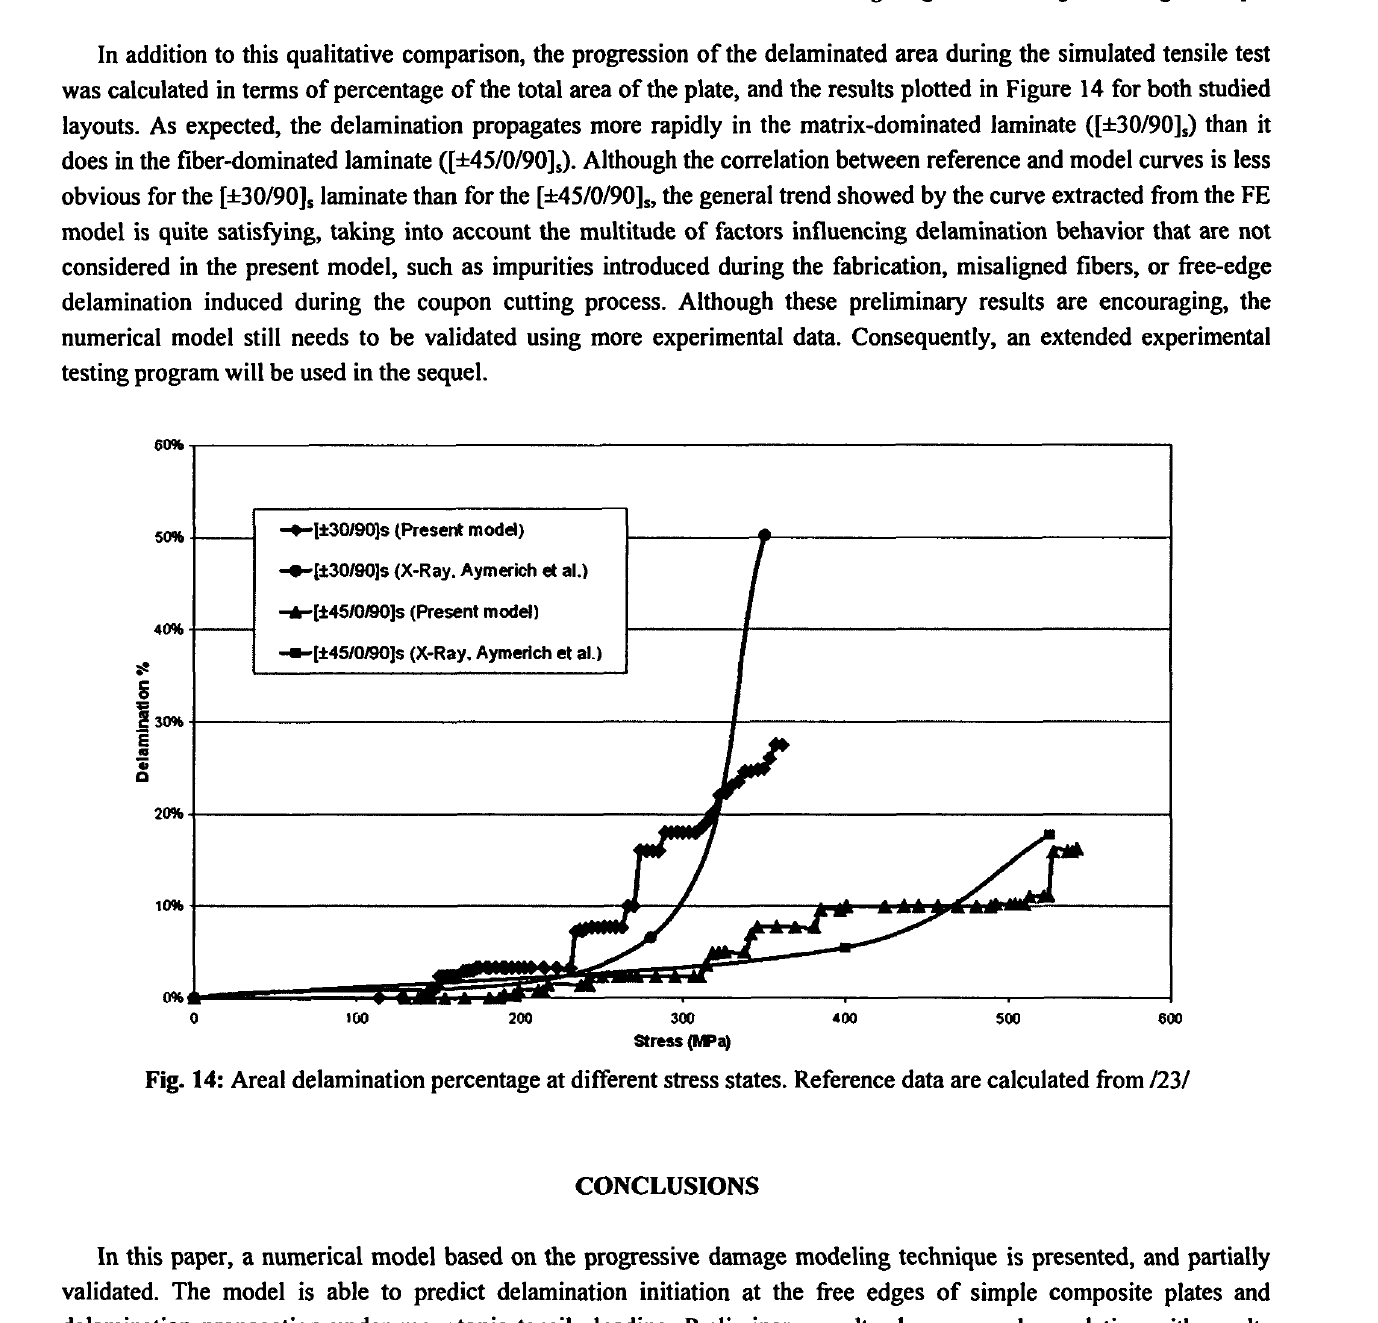
Fig. 14: Areal delamination percentage at different stress states. Reference data are calculated from